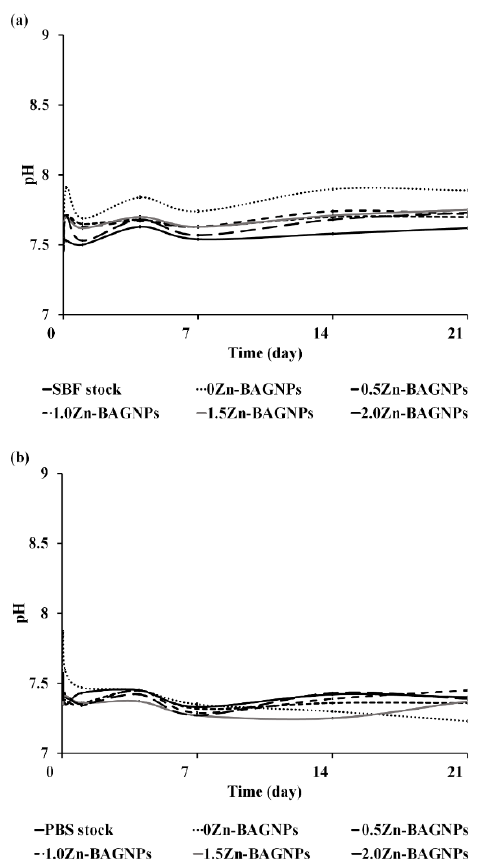
Figure 5. pH of ( a ) SBF and ( b ) PBS solution as a function of time after immersion of Zn-BAGNPs.